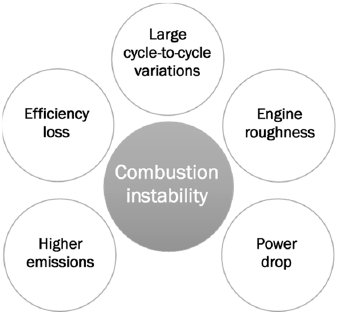
Figure 2. The effect of the uniqueness of engine work cycles.